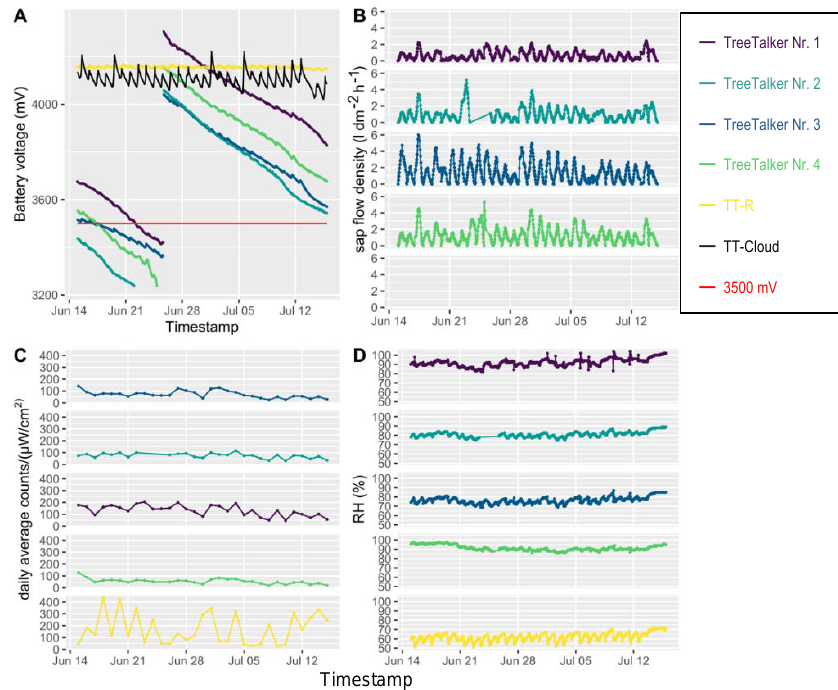
Figure 4. Output of the “ttalkR” plotting utility. ( A ) battery voltage with the indication of the warning threshold (3500 mV); ( B ) sap flow; ( C ) under canopy radiation; ( D ) relative humidity. The example data refer to four TreeTalkers and a TT-R for the period between 14 June 2021 and 14 July 2021. In ( B ), the data from the TT-R are missing because it is a reference device outside of the canopy which is not equipped with the corresponding sensors.